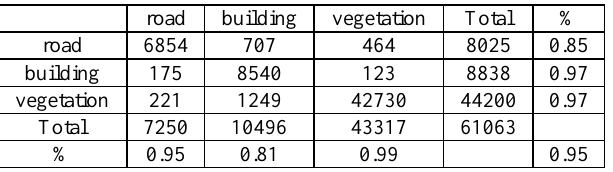
Table1. Confusion matrix for MSRF